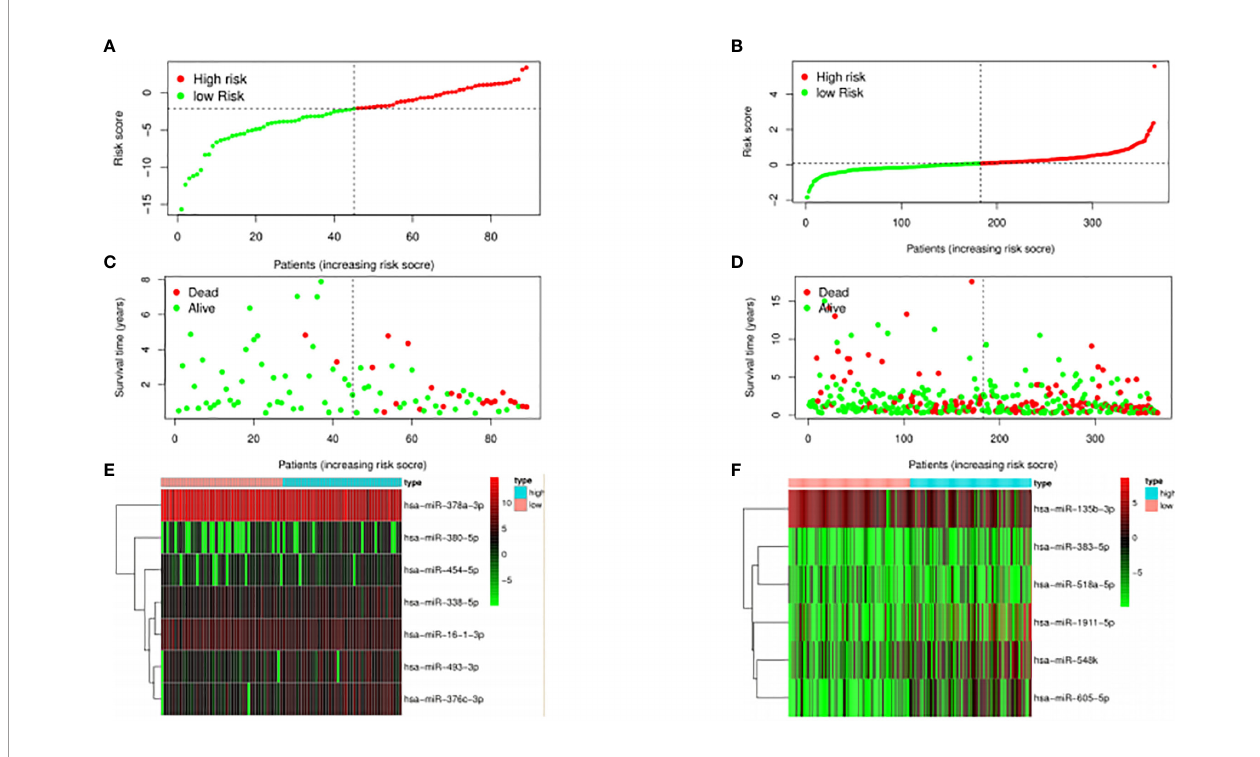
FIGURE 5 | Expression pro fi les of the signature.